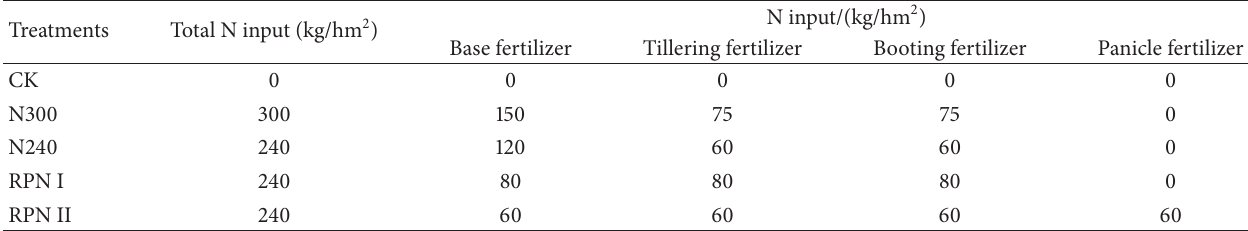
Table 2: Reducing and postponing N application experiment